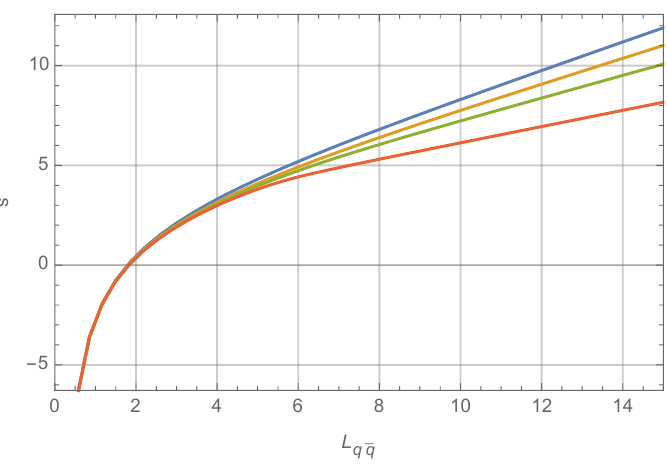
Figure 4 . The renormalized on-shell action for the fundamental string at (cid:11) = 0, as a function of L q (cid:22) q . The di(cid:11)erent lines correspond to di(cid:11)erent values of (cid:21) , namely (cid:21) = (0 ; 0 : 5 ; 0 : 7 ; 0 : 9), from top to